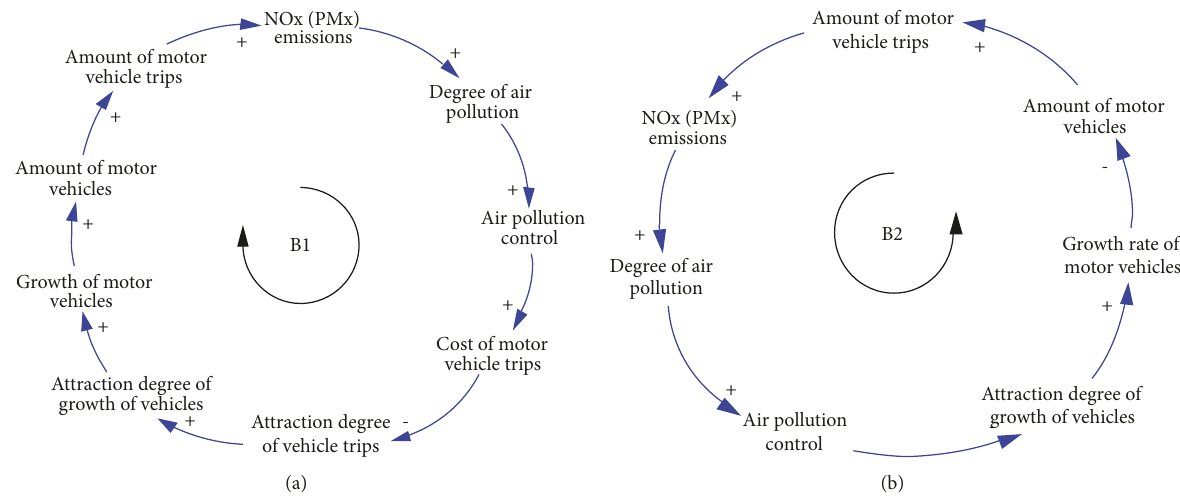
Figure 2: Major loops. (a) Negative feedback loop of NOx (PMx) emissions. (b) Negative feedback loop of